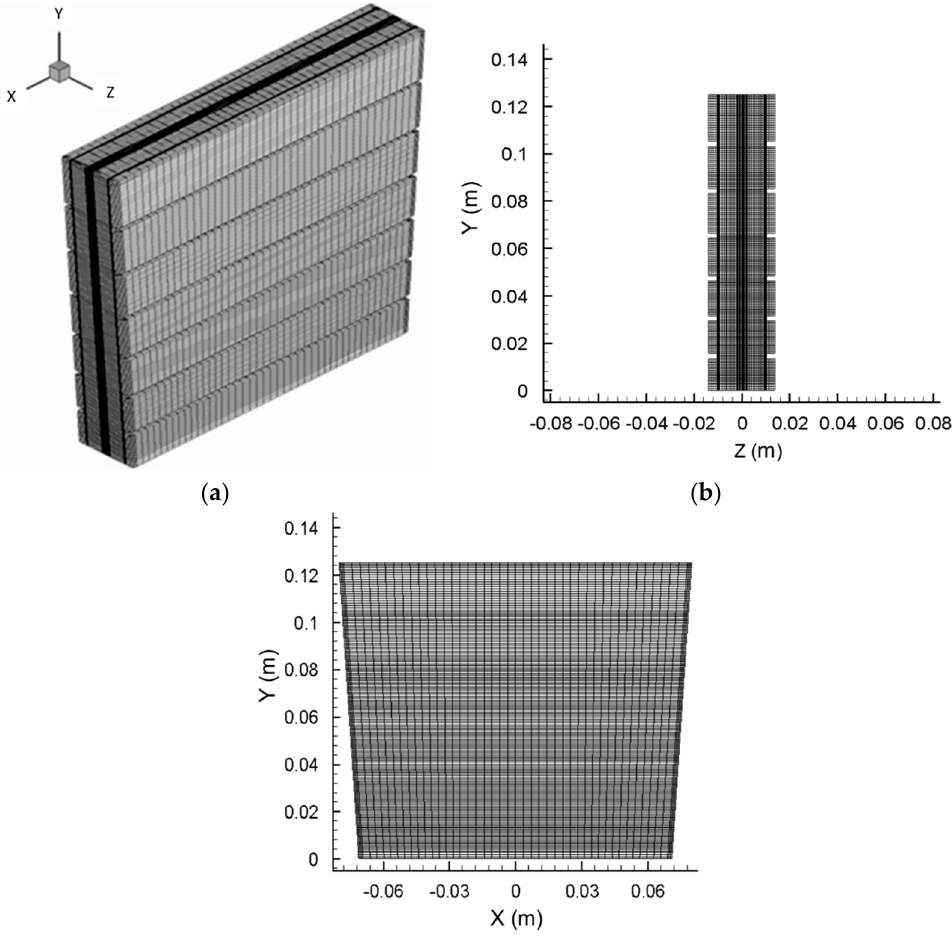
Figure 3. Numerical grids of a single Zn–air fuel cell. ( a ) Stereogram, ( b ) front and ( c ) side views.